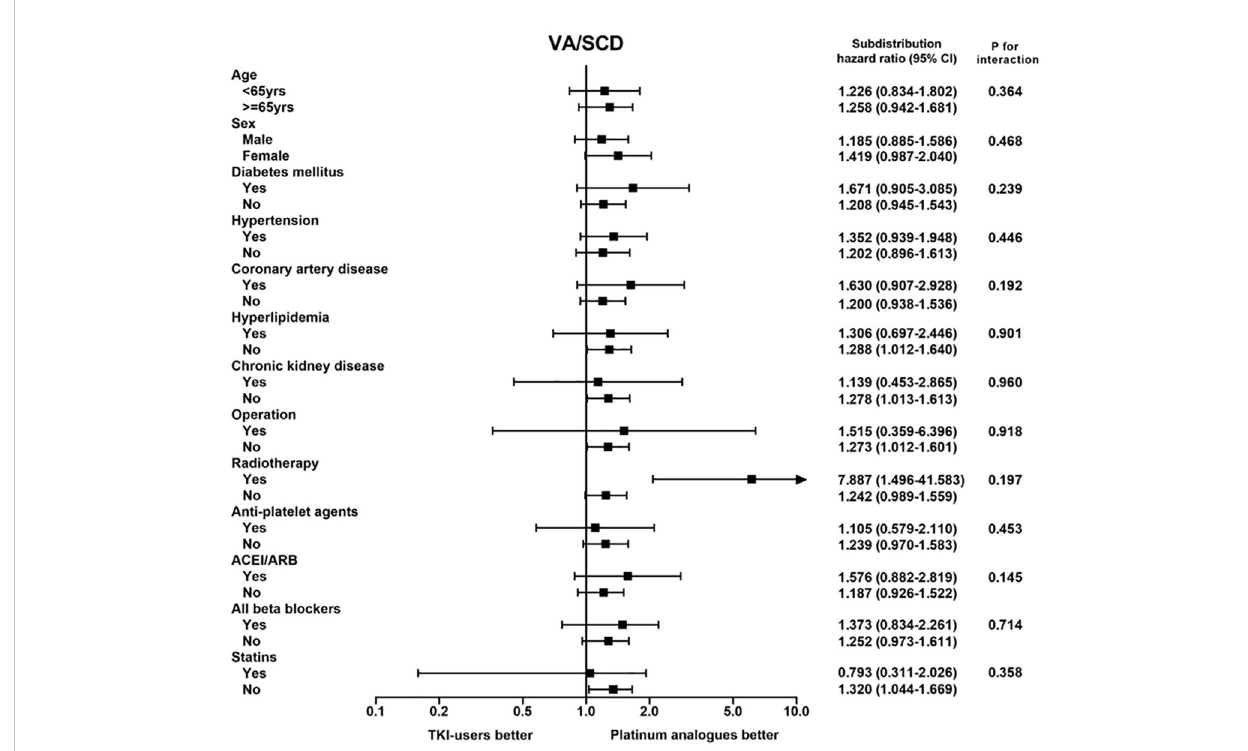
FIGURE 2 The subgroup analysis of the composition endpoint of ventricular arrhythmia (VA) and sudden cardiac death (SCD) between tyrosine kinase inhibitor (TKI) and platinum analogue users in patients with non-small cell lung cancers